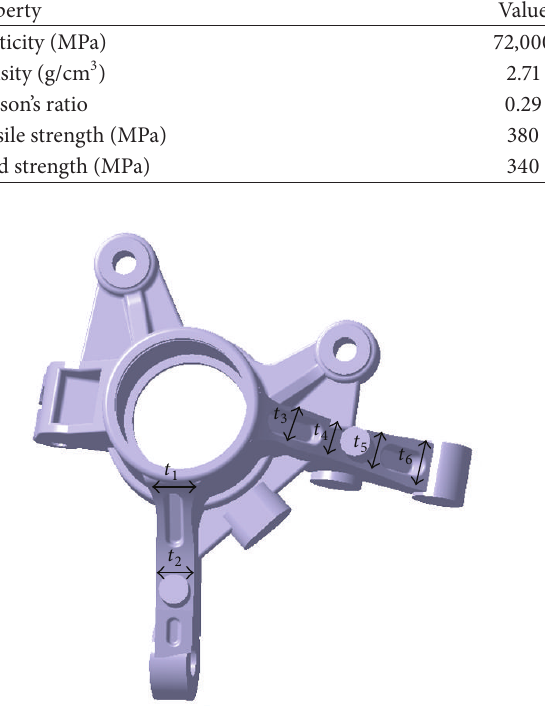
Figure 7: Definition of shape design